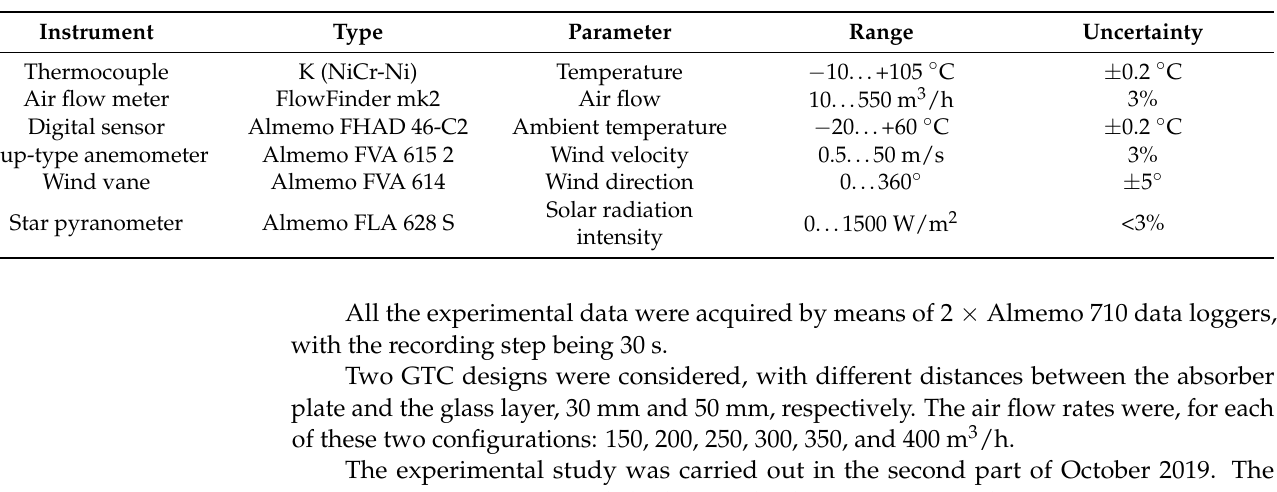
Table 1. Measuring devices’